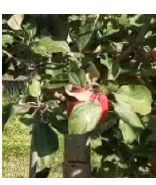
Figure 10. The leaf covers the apple and is predominantly visible. We avoid annotating such apples to avoid mistakenly detecting leaves as apples and will instead rely on the angle eventually making the apple clearer.